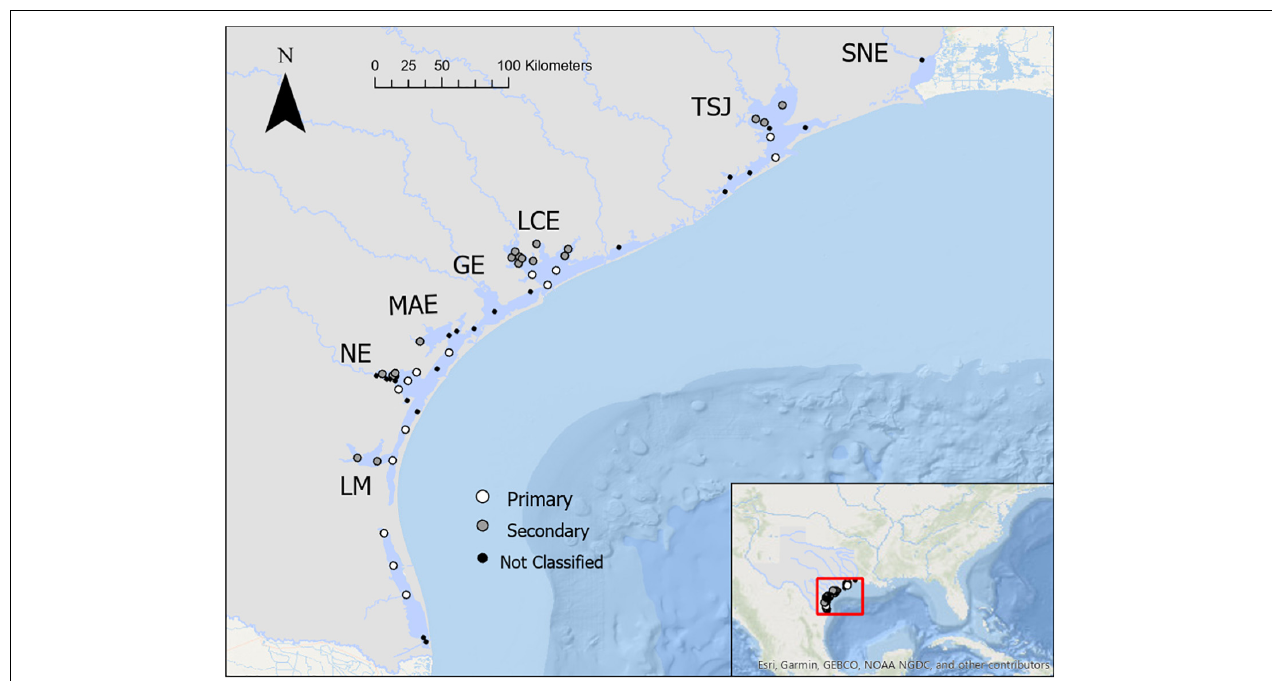
FIGURE 1 | A map of study locations. Texas Commission on Environmental Quality Surface Water Quality Monitoring stations that were used in the analysis (greater than 20 years of sampling for temperature, salinity, pH, and total alkalinity) are shown in each of the seven estuaries along the Texas coast. Station numbers can be found in Supplementary Figure 1